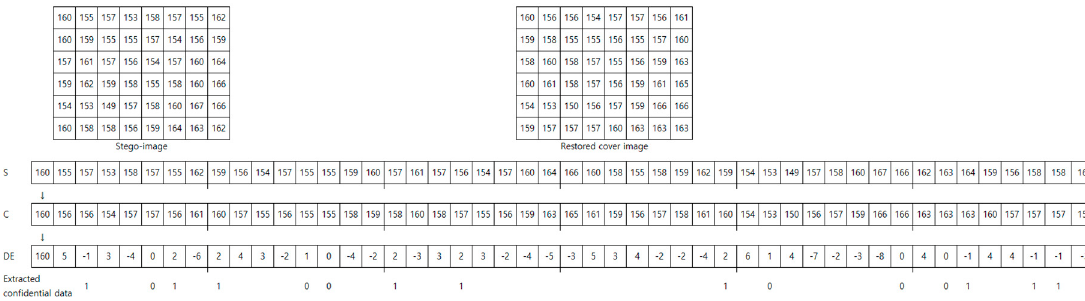
Figure 4. An example of data embedding using the APD technique. Figure 5. An example of data extraction and original cover image restoration using the APD technique.